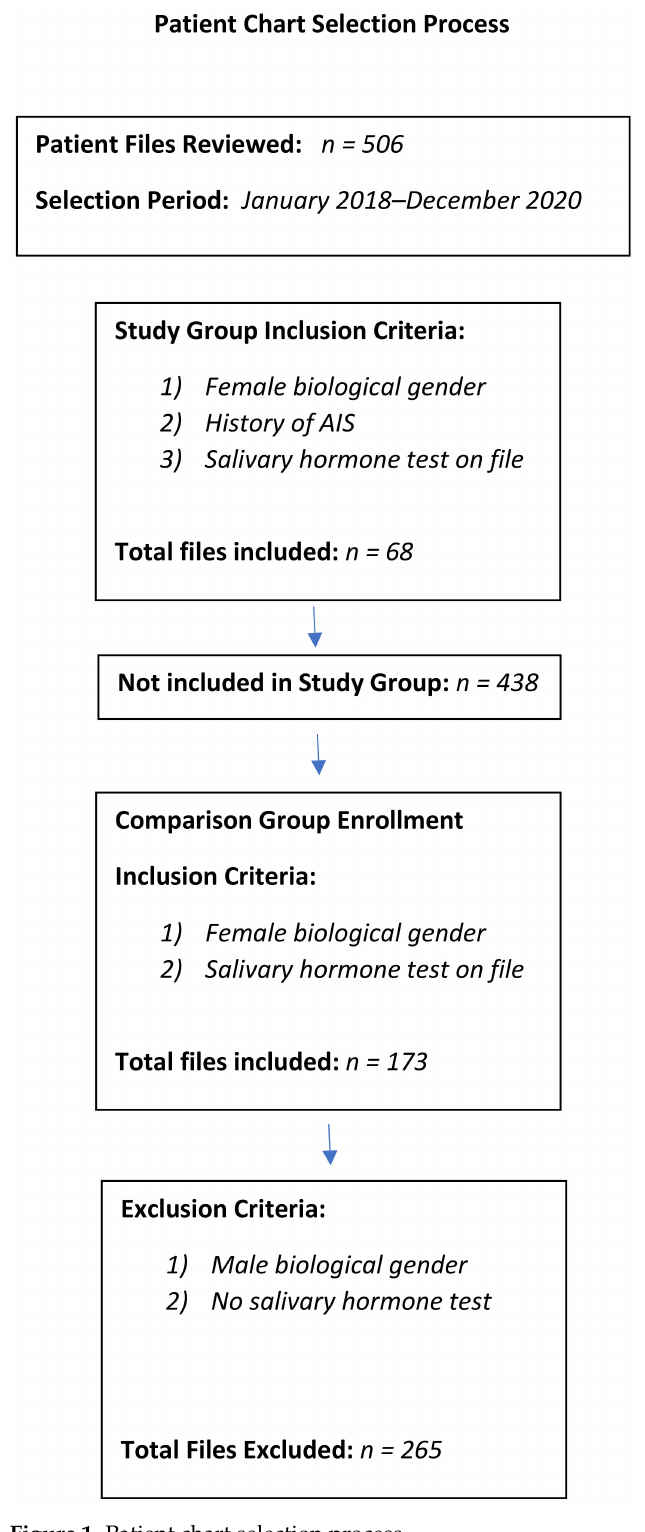
Figure 1. Patient chart selection